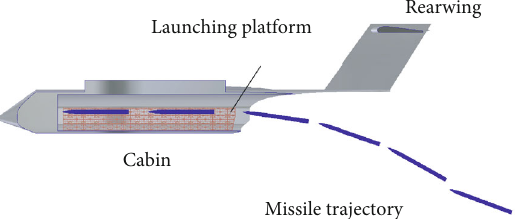
Figure 1: Horizontal backward launching.